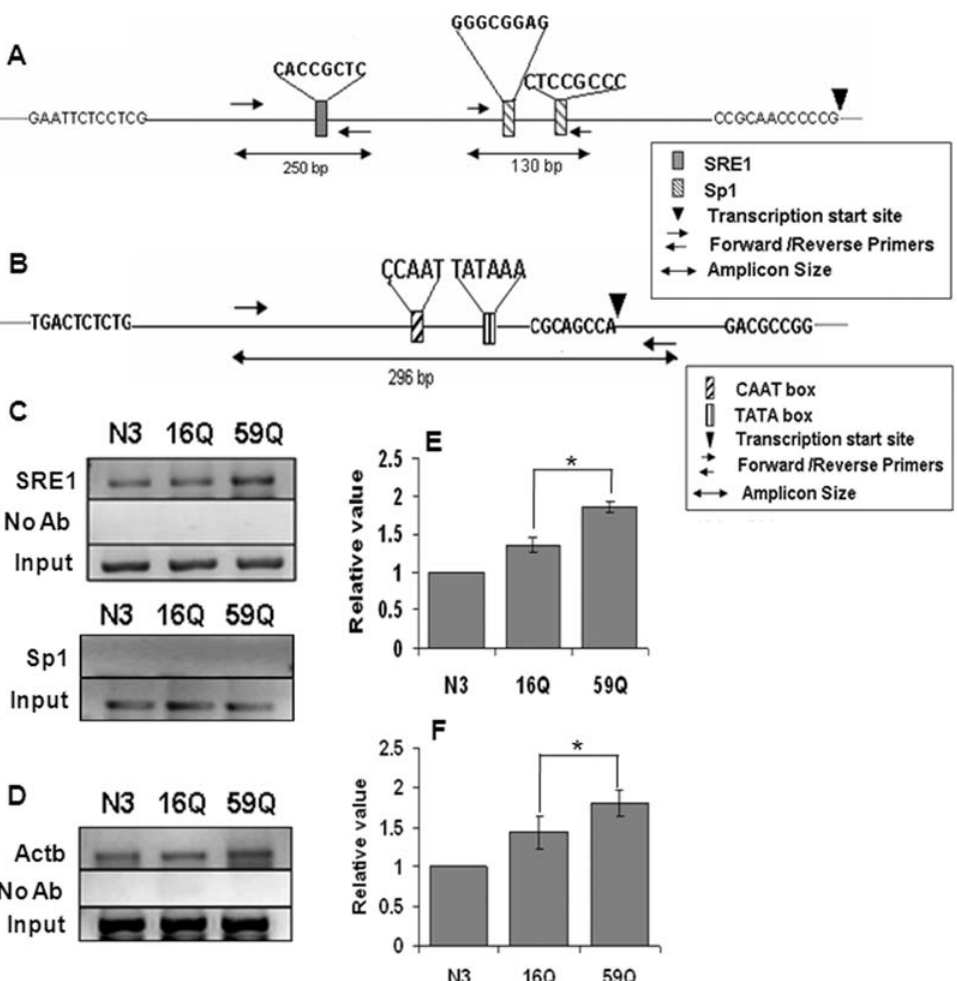
Figure 4.Chromatinimmunoprecipitation (ChIP) analysis revealedpromoterlocalization of TBP intransfected Neuro-2a cells. Promoteroccupancy of TBP was higher in 59Q TBPGFP transfected cells as compared to vector (N3) and 16Q TBPGFP transfected cells. (A & B) schematic representation of regulatory sites in Vdac1 promoter [predicted (16)] (A) and Actb promoter (B); SRE1: Sterol repressor element 1, Sp1: specificity protein 1. Cells transfected with 16QTBPGFP and 59Q TBPGFP were treated with 1% formaldehyde and chromatin prepared as described earlier [15]. Anti TBP antibody (N-12, Santa cruz) was used for immuno-precipitation. PCR was performed from immunoprecipitates, total input chromatin (Input). Samples treated without antibody (No Ab) did not show any product after PCR. PCR product for SRE1 (upper), Sp1 (lower) (C) and Actb promoter (D) were resolved on agarose gel. (E & F) intensity of band for SRE1 (E) and Actb promoter (F) were quantified and normalized to input band. Data represented relative to the N3 transfected control. Data shown are mean 6 SEM of three independent experiments performed. (*, p , 0.01, Student’s